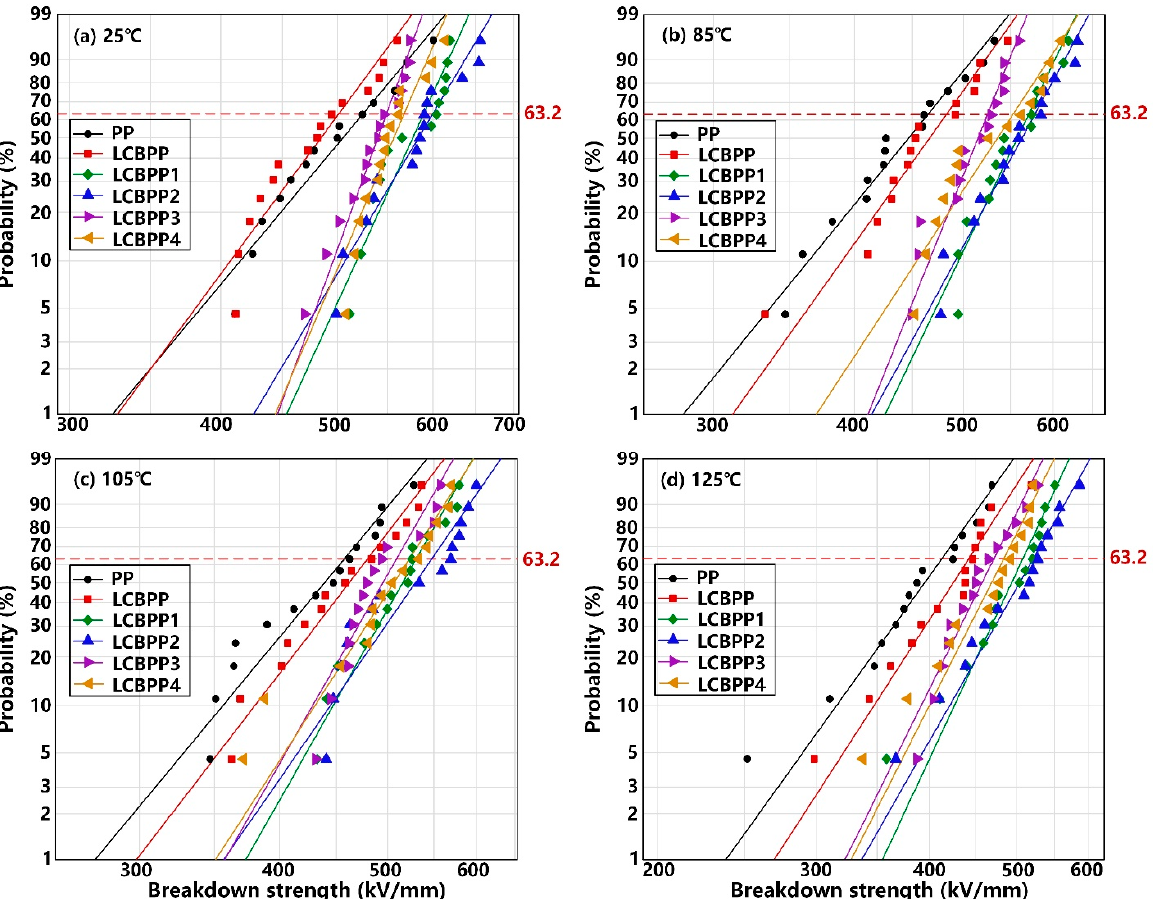
Figure 11. Relation between the breakdown strength and the α nucleating agents at different tem- peratures.